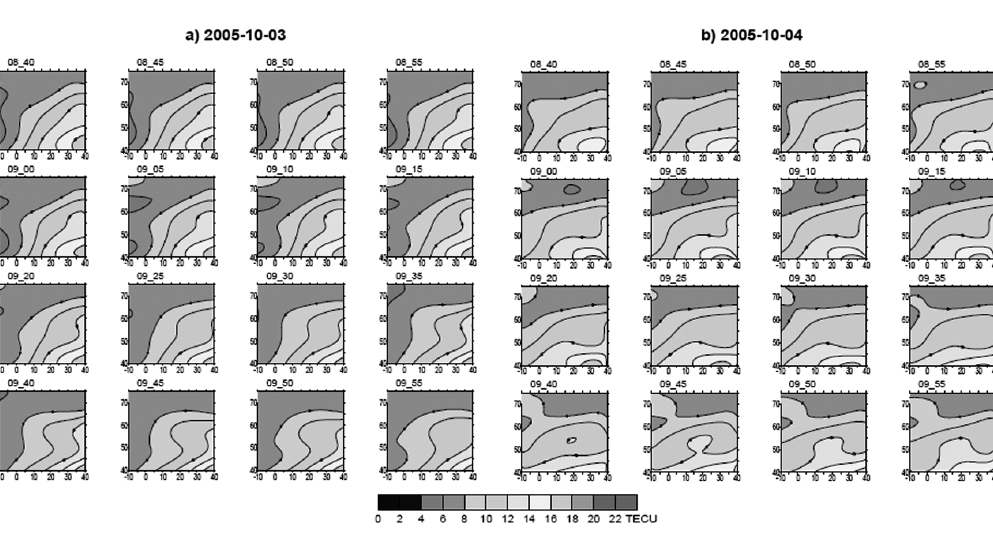
Fig. 2. The detailed TEC maps over Europe with 5-minute resolution during the eclipse day on 3 October 2005 (a) and one day after the solar eclipse on 4 October